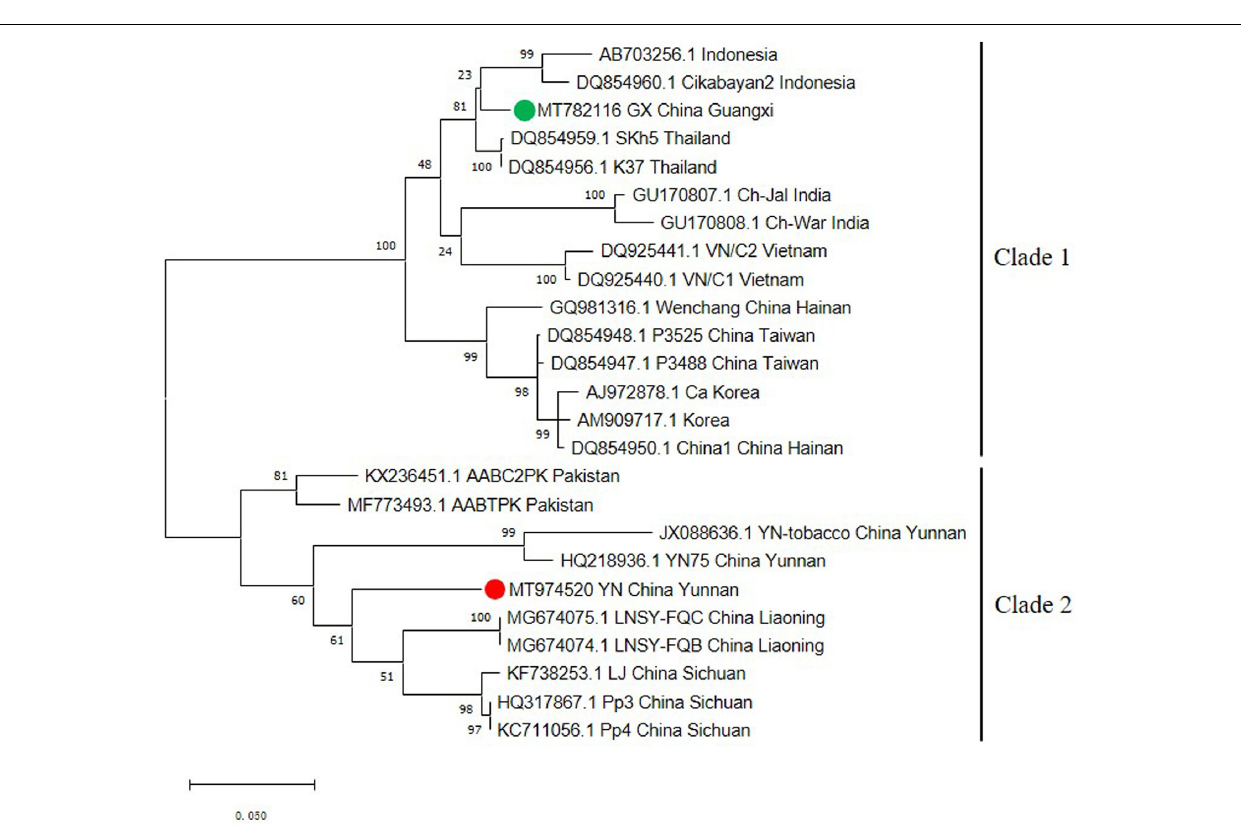
Frontiers in Microbiology | www.frontiersin.org